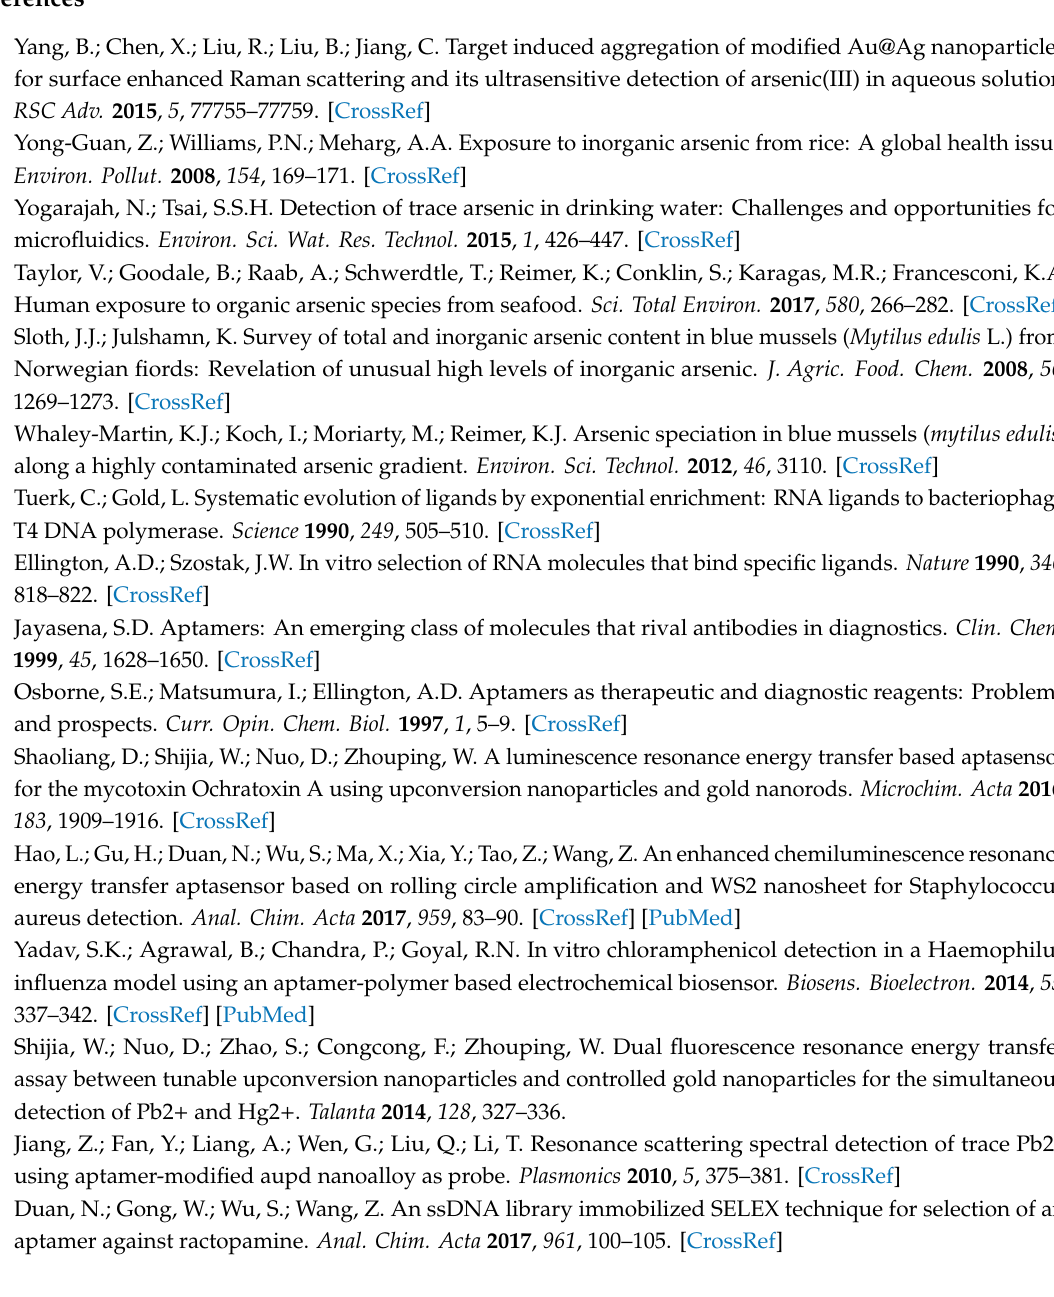
Figure S1: Dispersion of Zn 2 GeO 4 :0.50%Mn (ZGO:0.5%Mn) in aqueous solution; Figure S2: Fluorescence (FL) spectra of Zn 2 GeO 4 :0.10%Mn, Zn 2 GeO 4 :0.25%Mn and Zn 2 GeO 4 :0.50%Mn at same concentration which were excited at 250 nm; Figure S3: Partially enlarged XRD spectra of Zn 2 GeO 4 :0.10%Mn, Zn 2 GeO 4 :0.25%Mn and Zn 2 GeO 4 :0.50%Mn with 2 θ in the range of 30 ◦ –40 ◦ ; Figure S4: EDS analysis of (a) Zn 2 GeO 4 :0.10%Mn,